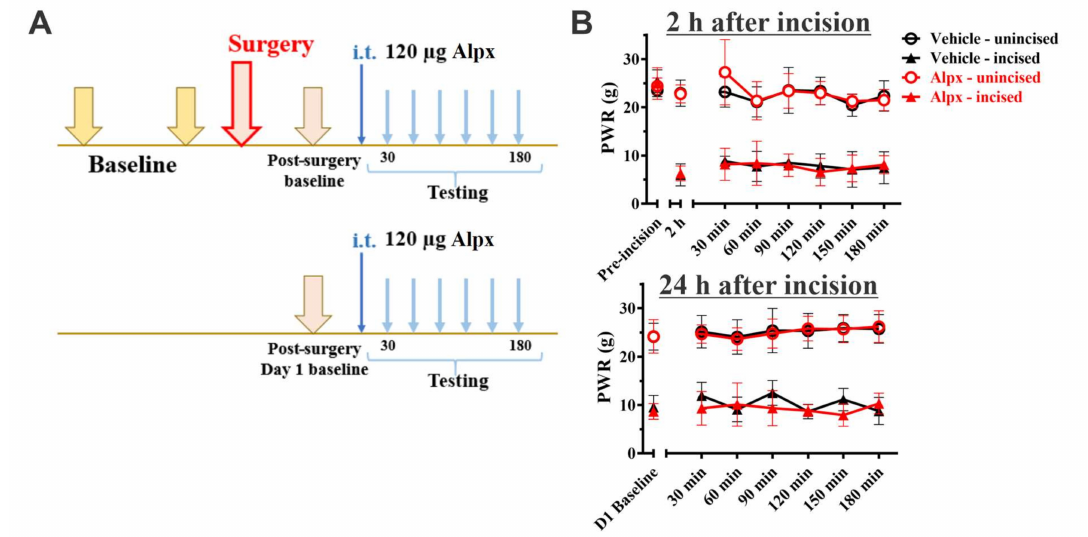
Figure 3. Repeated administration of Alphaxalone does not a ff ect postincisional mechanical hypersensitivity in rats. ( A ). A time-course showing baseline measurements to mechanical stimuli two days before incision, two hours and 24 h after incision. The paw withdrawal responses were measured every thirty minutes after i.t. injection of 120 µ g Alpx. ( B ). Repeated administration of 120 µ g Alpx at 2 h (top; n = 5 per group) or 24 h after incision (bottom; n = 6 per group) does not alleviate mechanical hypersensitivity in rats. Each data point is represented as mean ± SD. Data were analyzed using Two-way RM ANOVA.